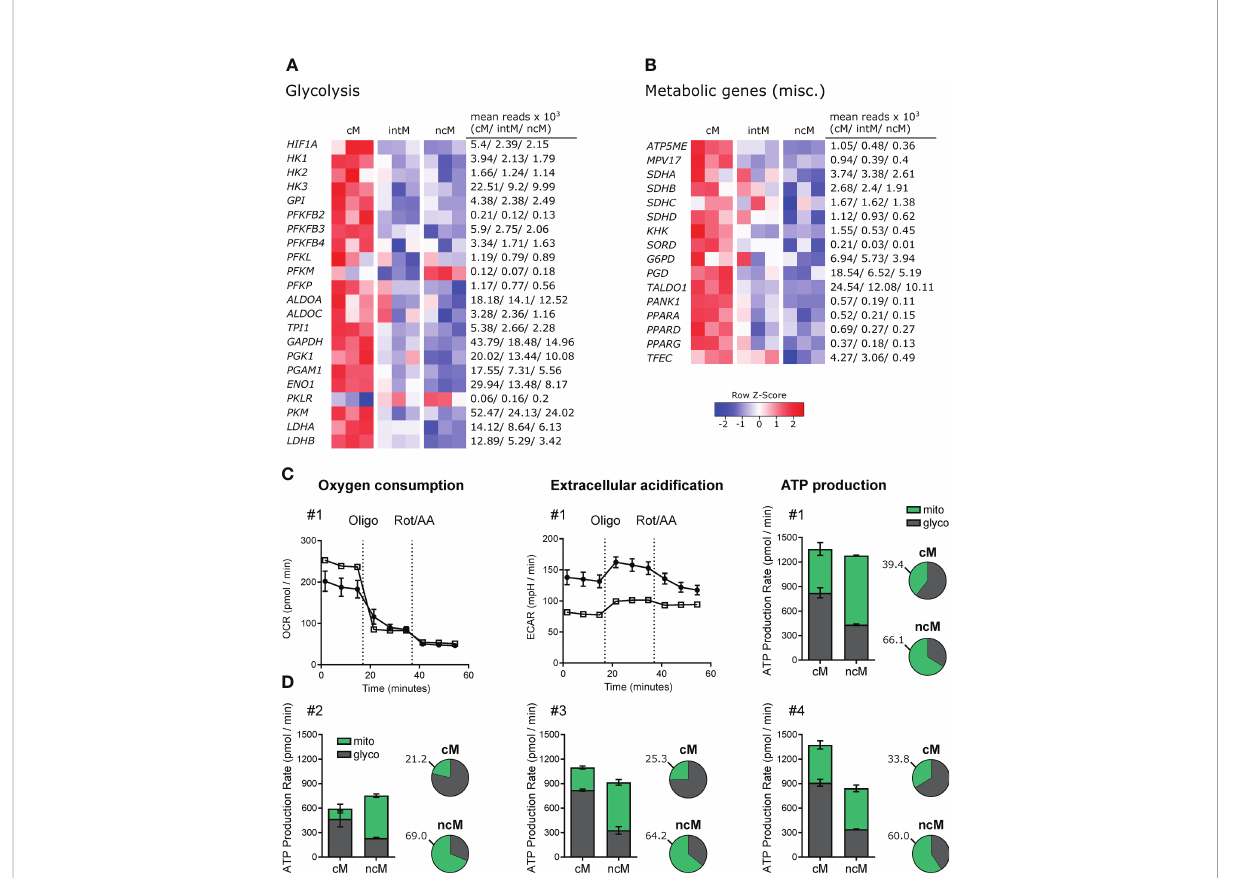
FIGURE 6 Metabolic gene expression and Agilent Seahorse Assays. (A, B) Illumina sequencing was performed on RNA isolated from sorted monocyte subsets (cM, intM, ncM) of three animals. Heatmaps show row z-scores calculated from log2-transformed normalized counts of glycolytic genes (A) and of genes associated with other metabolic pathways (B) . Mean kilo reads for each subset and gene are given to the right of each heatmap. Genes were selected based on pairwise comparisons with DESeq2 (adjusted p-value < 0.05) and literature research. (C+D) Bovine monocyte subsets were FACS-sorted and metabolic activity was analyzed by Agilent Seahorse XF technology and the XF Real-Time ATP Rate Assay. Oxygen consumption rate (OCR) and extracellular acidi fi cation rate (ECAR) were automatically calculated from measured oxygen and pH decrease (Agilent Wave software). The electron transport chain inhibitors oligomycin and rotenone/antimycin A were injected sequentially to allow calculation of OXPHOS- as well as glycolysis-mediated ATP production rates (mito, glyco) from resulting OCR and ECAR. Monocyte subsets from four animals were analyzed. (C) For one representative animal, OCR and ECAR traces are depicted in addition to ATP production rates which are shown as absolute values (bar graphs) and relative values (pie charts). (D) ATP production rates for three other animals. Data of intM (2 animals) and monocyte-derived macrophages (2 out of 3 animals) is shown in Supplementary File